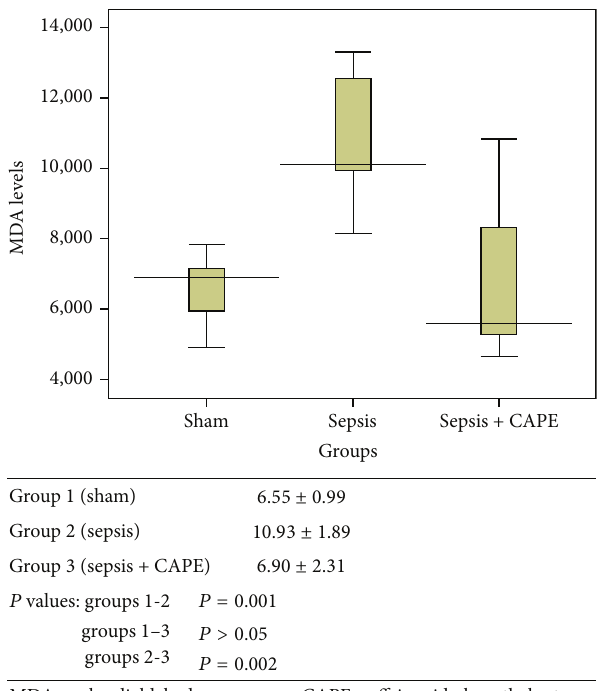
Figure 3: Tissue MDA level (nmolg −1 protein) was described as mean value ± SD for all groups.